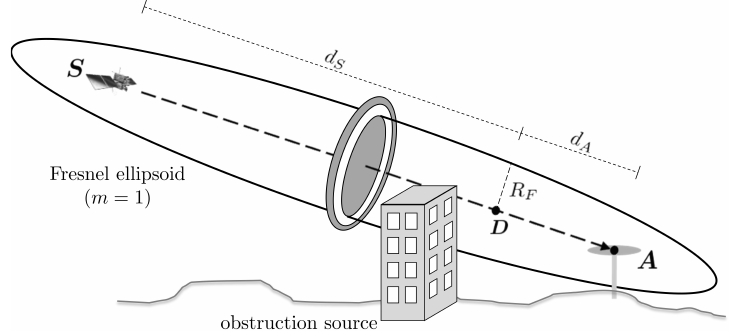
Figure 8. Fresnel ellipsoid of the first order for line-of-sight transmission between the satellite S and the antenna A including a building obstructing the signal path and parts of the first Fresnel